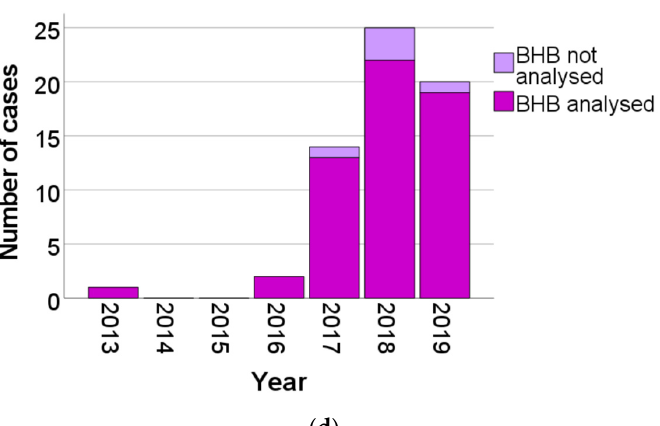
Figure 1. ( a ) Number of DKA (diabetes ketoacidosis) cases, separated as BHB analysed or not analysed. ( b ) Number of AKA (alcoholic ketoacidosis) cases, separated as BHB analysed or not analysed. ( c ) Number of hypothermia cases, separated as BHB analysed or not analysed. ( d ) Number of cases of acidosis NOS (not otherwise specified) per year, separated as BHB analysed or not analysed.